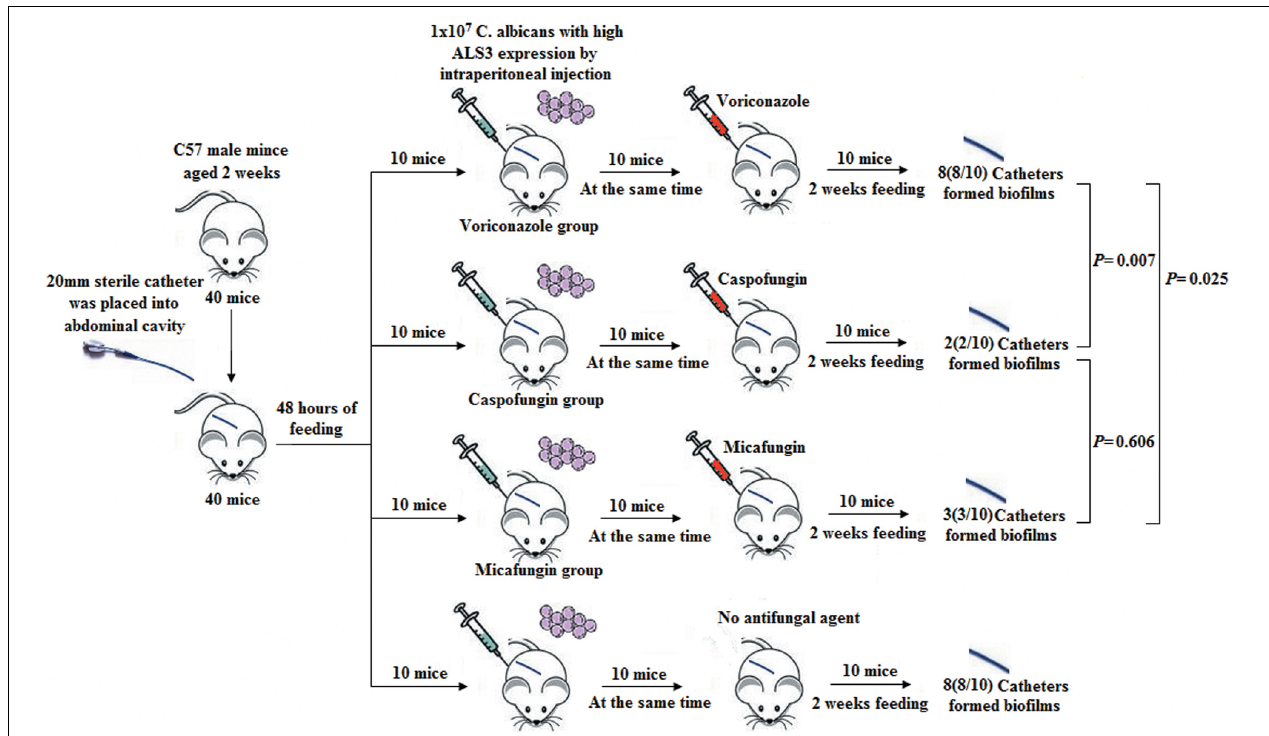
FIGURE 5 | Prevention of biofilm formation in mice. Eight C. albicans (8/10, 80%) in voriconazole group, two C. albicans (2/10, 20%) in caspofungin group and three C. albicans strains (3/10, 30%) in micafungin group formed biofilms with membrane structure attached in the wall of catheters under microscope. The rate of biofilm formation in the caspofungin group and in the micafungin group were lower than that of in the voriconazole group, respectively ( P caspofungin = 0.007 and P micafungin = 0.025). But there was no different of the biofilm formation rate in the caspofungin and micafungin group ( P =